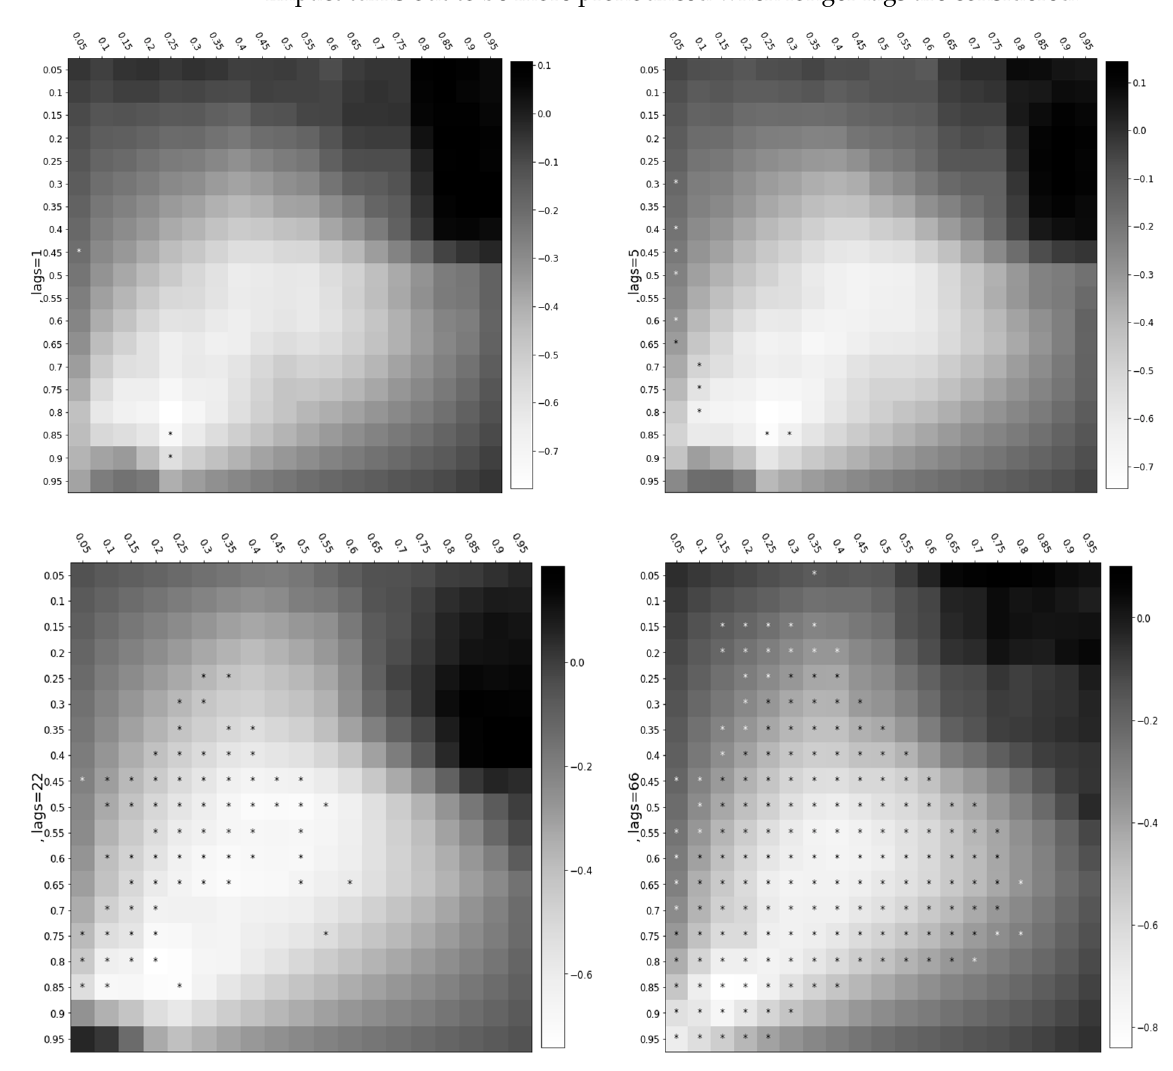
Figure 6. Cross-quantilogram dependence from Sinopharm to AstraZeneca. Notes: The vertical axis indicates the quantile distribution of Sinopharm’s stock return, whereas the horizontal axis indicates the quantile distribution of AstraZeneca’s stock return. The white-to-black intensity in the bar indi- cates negative to positive associations.